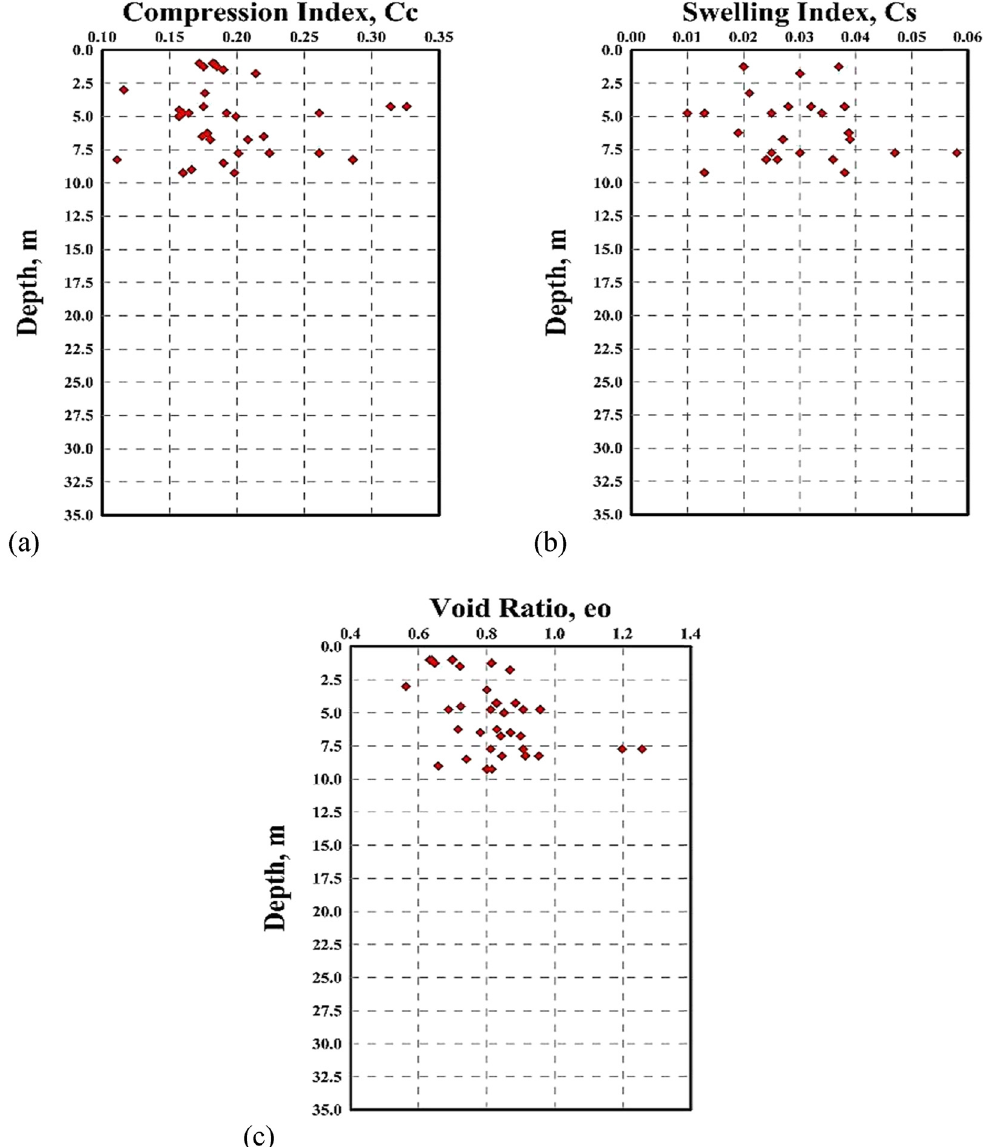
Figure 9: Variation of the c c , c s , and e o with depth: ( a ) compression index ( c c ) , ( b ) swelling index ( c s ) , and ( c ) void ratio ( e o )